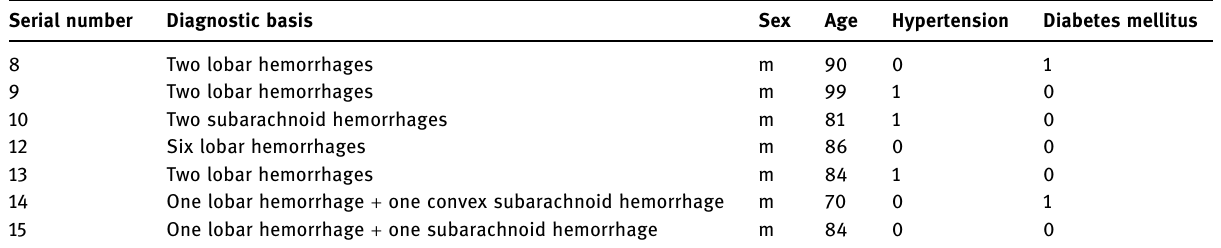
Table 1: Summary of the general and clinical information of probable CAA patients with more than one time of ICH ( n = 7 ) Serial number